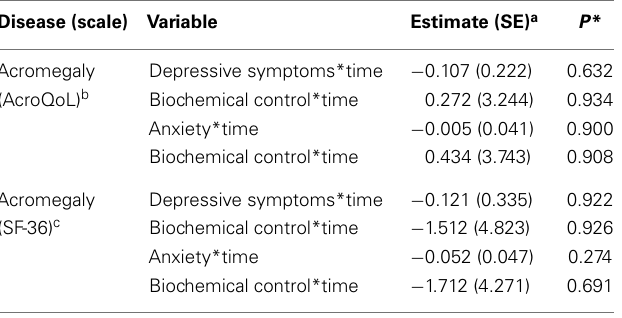
Table 4 |Association of psychopathology/biochemical control and progression of QoL .